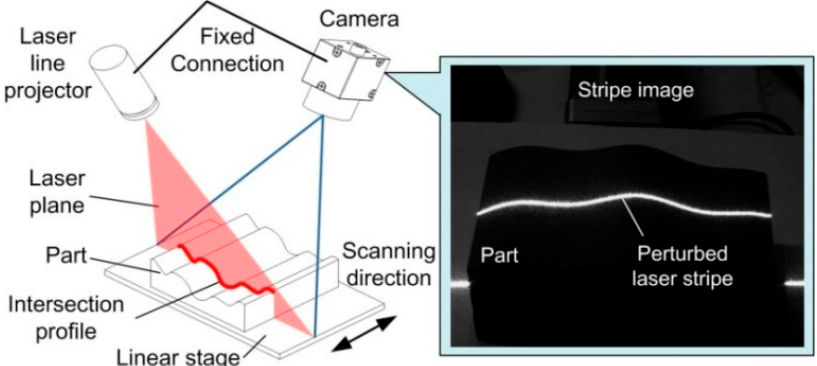
Figure 1. Measurement principle of the laser line scanning system.